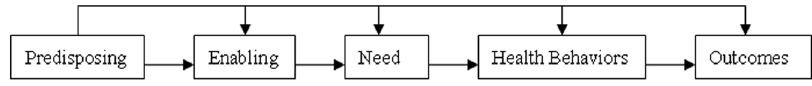
Figure 1. Andersen’s behavioral model.